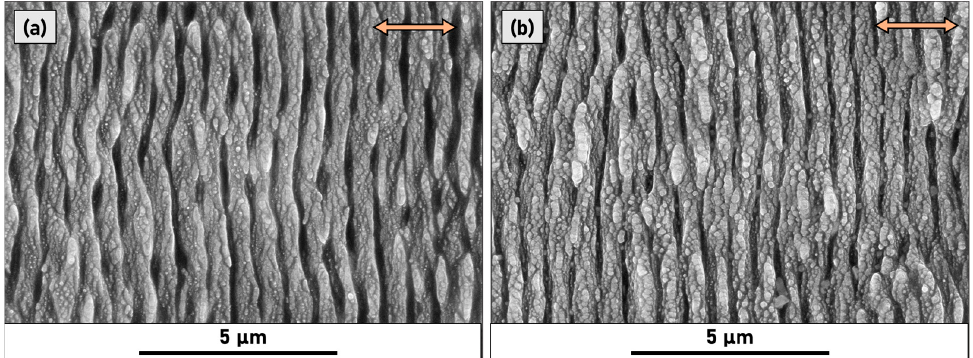
Figure 4. SEM micrographs of ( a ) sample P50 and ( b ) sample P160. The red arrows indicate the laser polarisation direction.